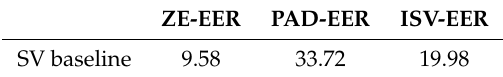
Table 1. Difference in equal error rate (EER) according to the existence of replay non-target trials. Results demonstrate the vulnerability of speaker verification systems that are unaware of presentation attack detection (PAD).